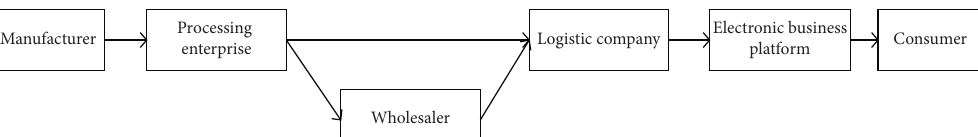
Figure 3: Fresh food e-commerce supply